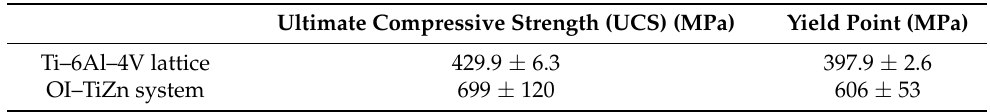
Table 1. Statistical deviations of the mechanical properties under compressive loading of Ti-base lattice and OI–TiZn system.